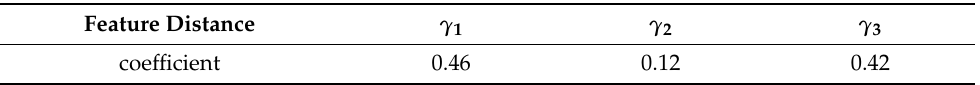
Table 1. Optimal weights of the three feature distances for precipitation